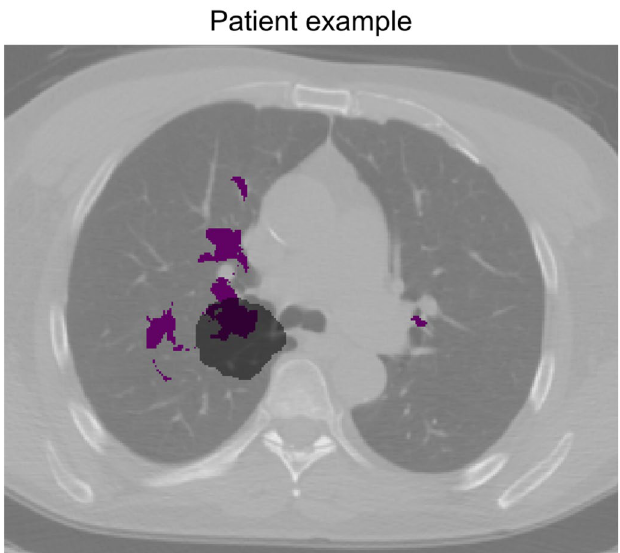
Figure 5. Example of an RCT2 patient with the primary tumor shown in gray and RCT1-decreased survival areas (DSA) shown in violet on an axial CT slice of the reference